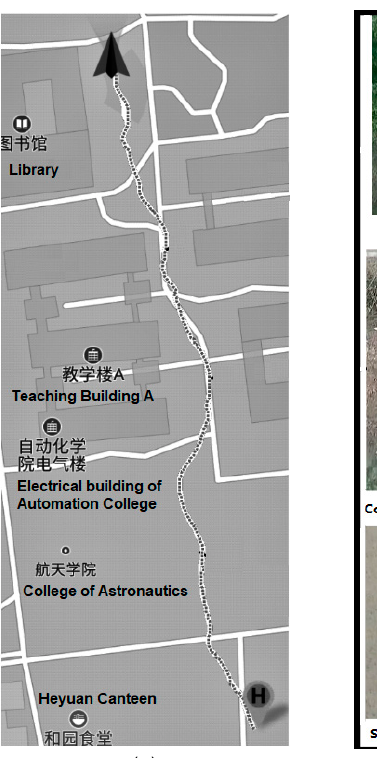
Figure 14. The scene of the tracking experiment.